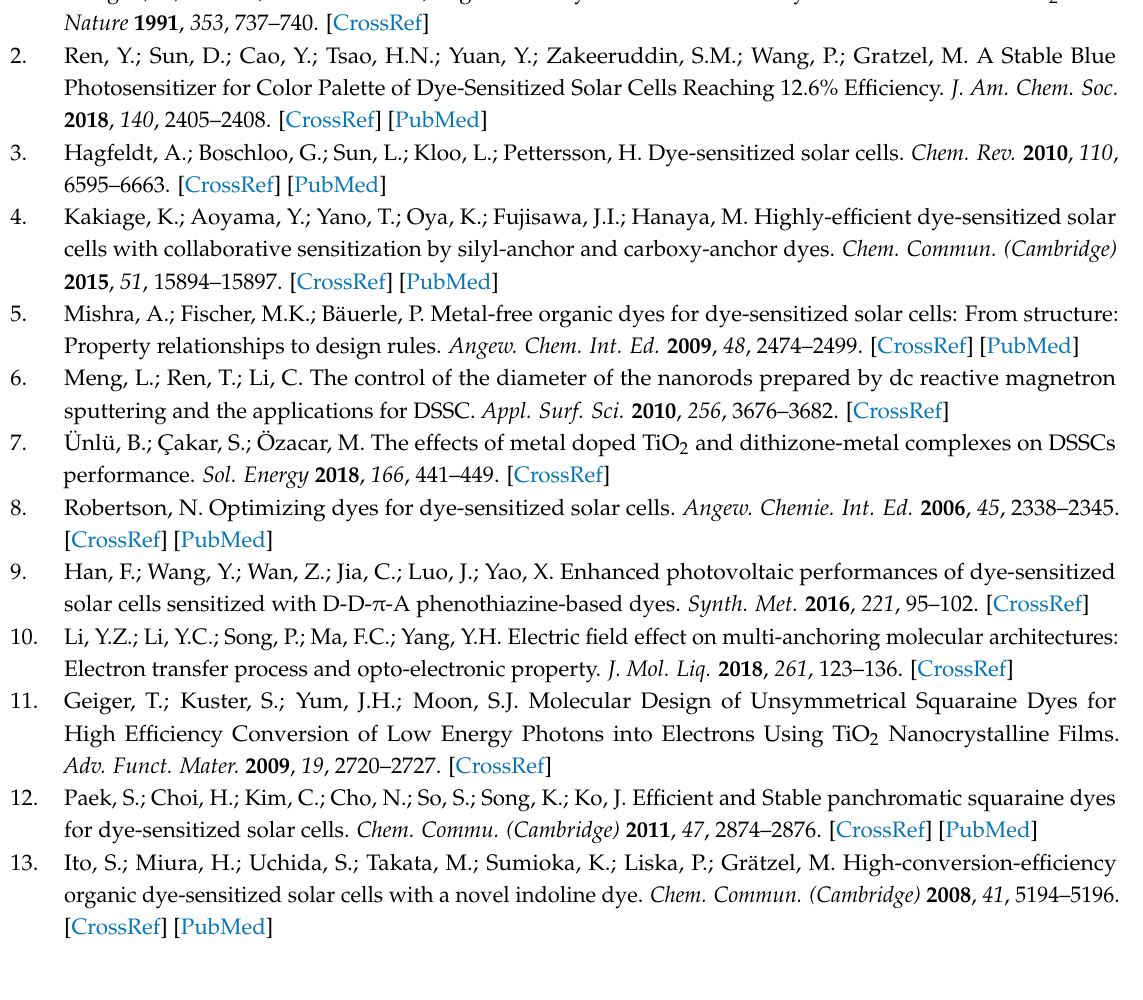
s1, Figure S1. Charge difference density (CDD) of the selected excited state for dyes in solvent. (Green and red stand for the hole and electron, respectively), Figure S2. Frontier molecular orbital of molecular designing in DMF solvent. Figure S3. The UV-Vis absorption spectrum in DMF solvent. Table S1. Energy levels of HOMO and LUMO and energy gaps calculated by DFT in vacuum and DMF solvent of three dyes. Table S2. The ionization potentials(IP) and electron affinities(EA) of LS-385, LS-386 and LS-387 in vacuum and solvent. Table S3. Calculated the static first hyperpolarizability of the three dyes in vacuum and DMF solvent. Table S4. The bond length of LS-387 analogous in DMF solvent. Table S5. Dihedral angle in DMF solvent. Table S6. The energy level and the energy gap in DMF solvent. Table S7. Transition energies ( E g ) and oscillator strengths of 15 designed molecules in DMF solvent. Table S8. The Electrochemical Parameter in DMF solvent. Cartesian coordinates of the optimized